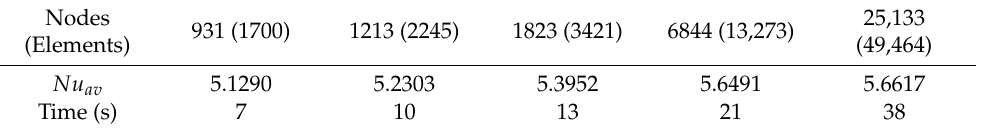
Table 1. Inquiry of grid refinement at Ri = 1, λ = 2, Pr = 0.71, H = 0.50, and L = 0.45.